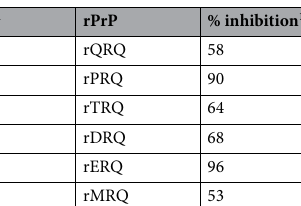
Table 1. Inhibition of scrapie replication with 100 nM rPrP variants at position 136. 1 Dotblots of PMCA products were analysed by densitometry and the PrP Sc signal above background (1200 nM rVRQ inhibition) were expressed as a percentage inhibition of the no inhibition control. Each sample was analysed in 8 replicate PMCA amplifications and the average % inhibition is shown. Analysis of inhibition versus a no inhibition control was carried out using a one-way ANOVA with Dunnett’s multiple comparison test for each rPrP, all rPrPs demonstrated significant inhibition except rFRQ ( p = 0.12) and rNRQ ( p = 0.89).